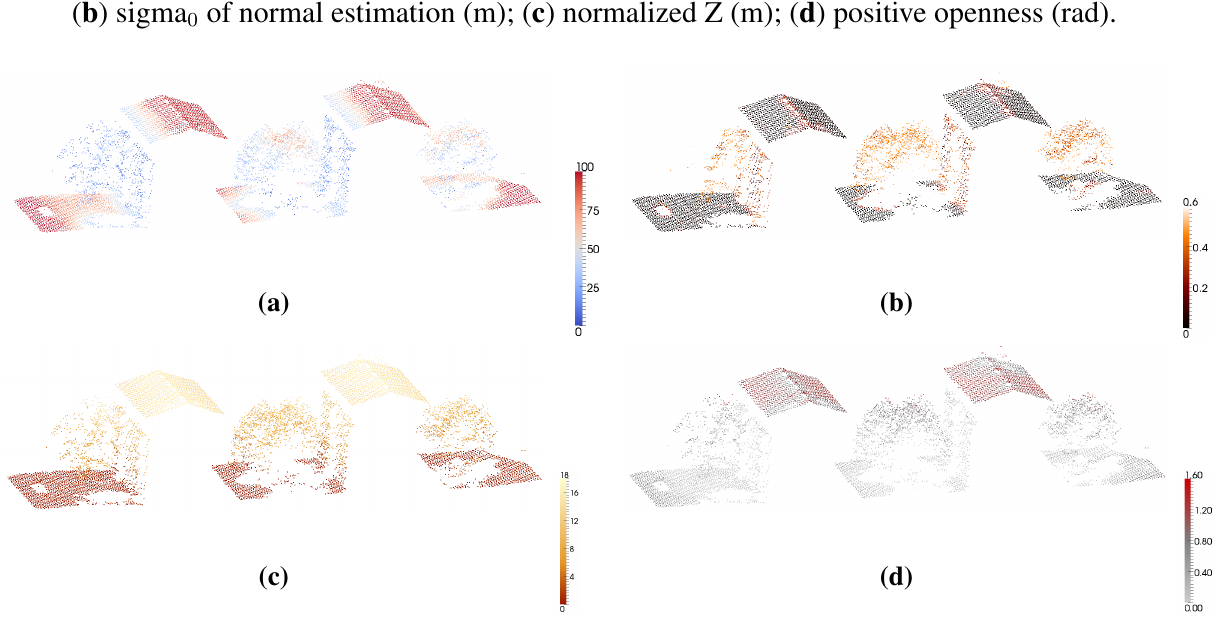
Figure 8. Example of different level 2 point cloud features. ( a ) Echo ratio feature